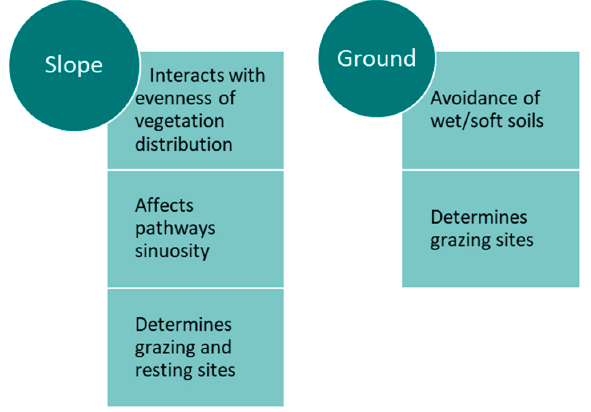
Figure 12. Main characteristics of the effect of slope and ground conditions on the distribution of cattle in the landscape.